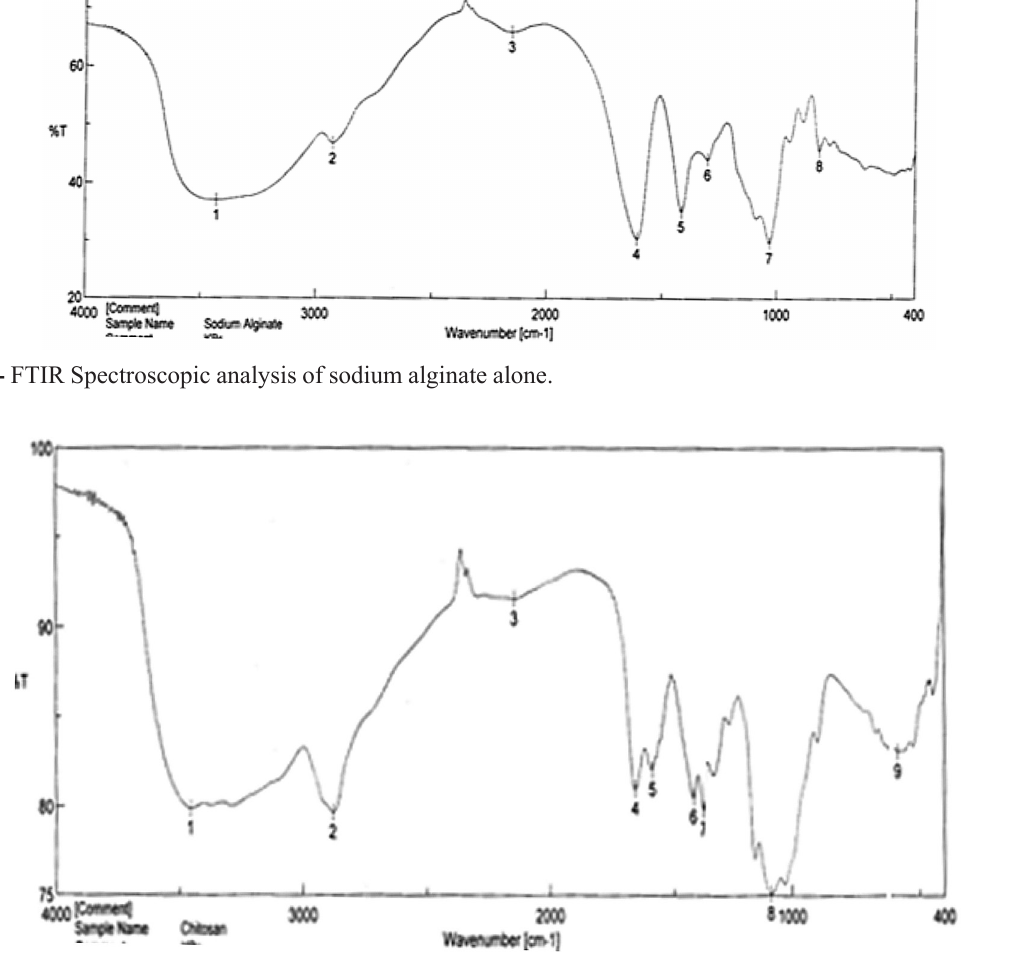
FIGURE 7 (c) - FTIR Spectroscopic analysis of sodium carboxymethyl cellulose.